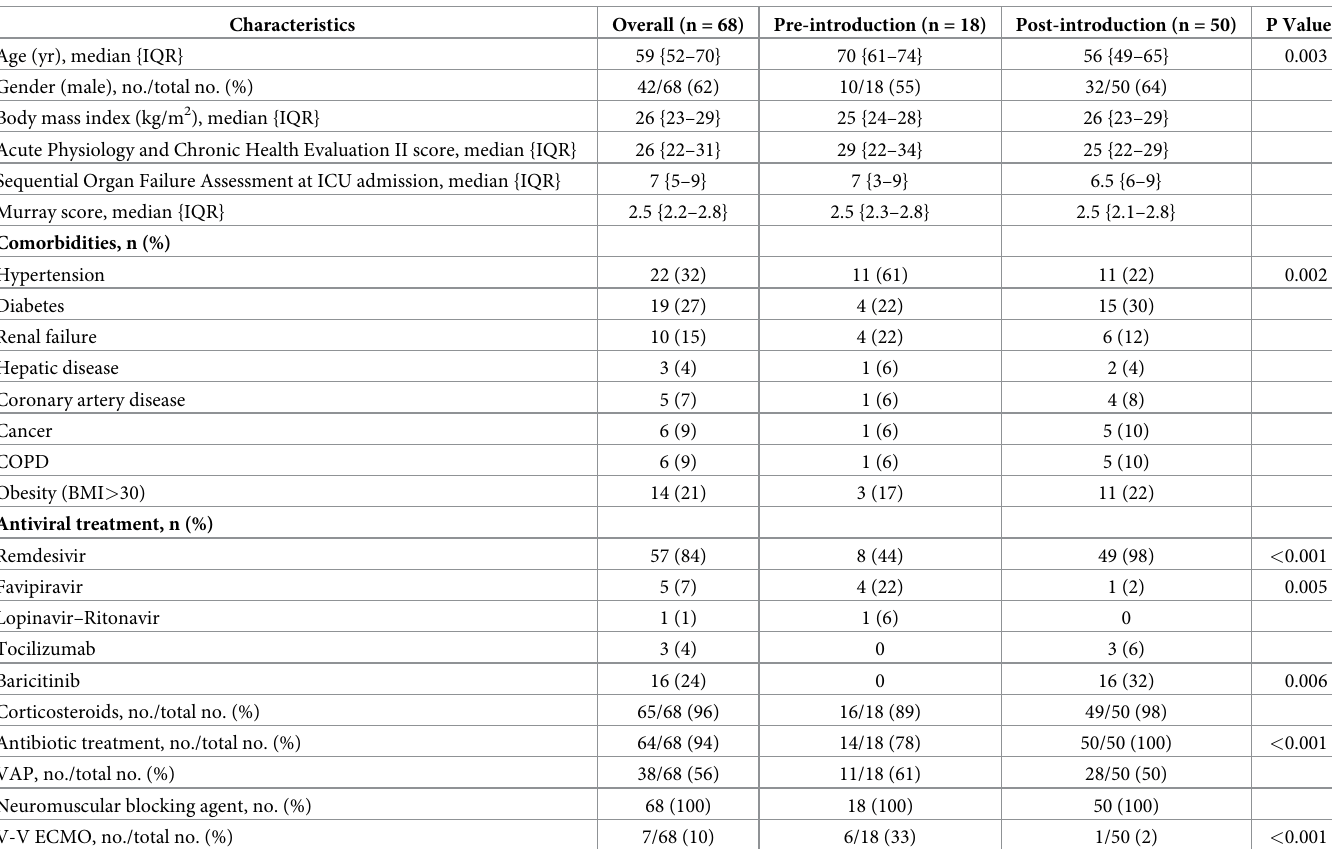
Table 2 shows the parameters of ventilation, prone positioning, and complications associated with prone positioning. Table 1. Baseline characteristics.